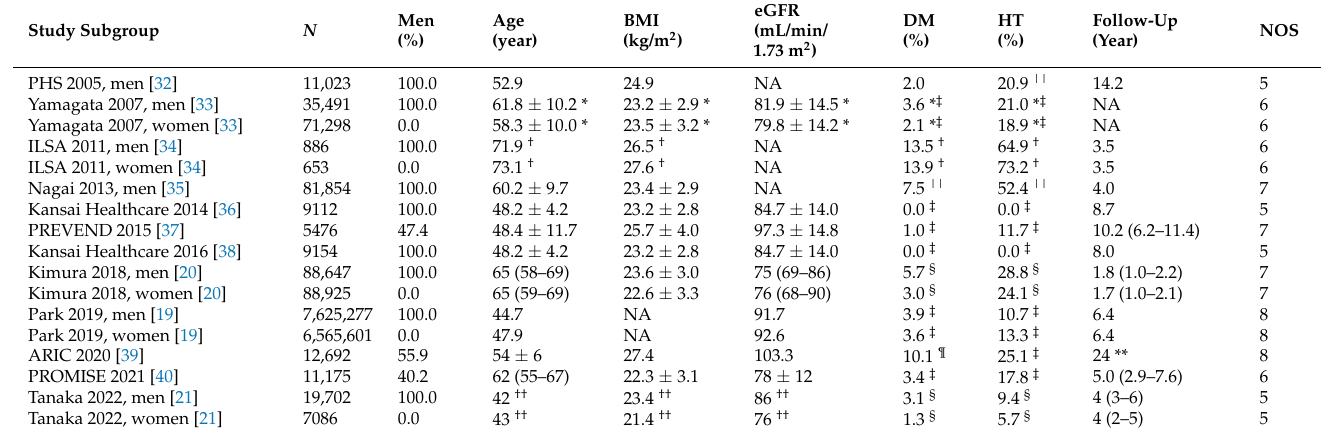
Table 2. Clinical characteristics of 12 publications of 11 cohort studies stratified by sex